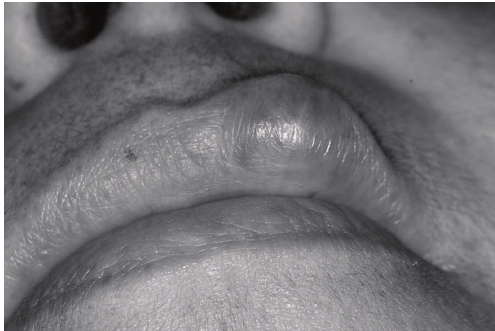
Figure 3: Clinical aspect of submucous nodule following scle- rotherapy.